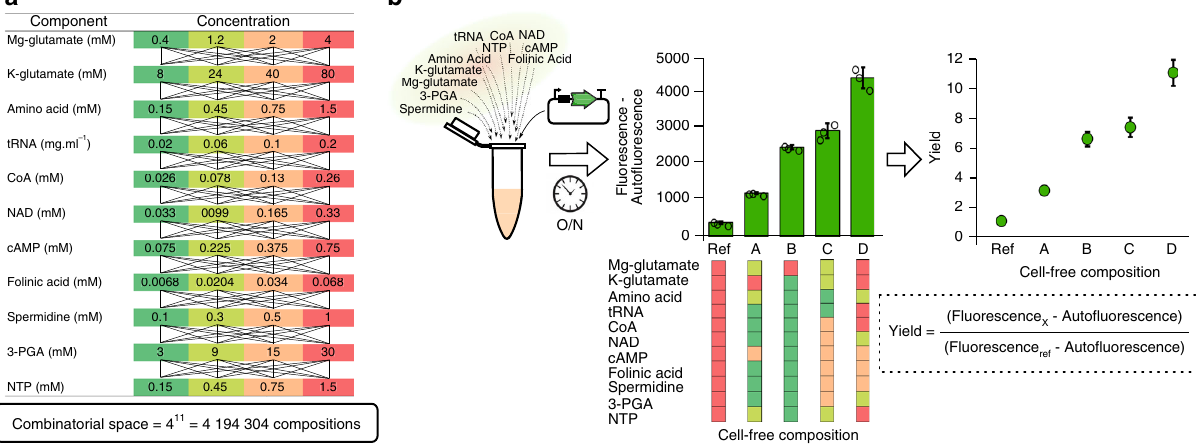
Fig. 1 Combinatorial space of the buffer composition of a cell-free system. a List of chemicals added to the cell-free mix in addition to PEG-8000, HEPES, and the lysate. Four concentrations have been chosen for each chemical. The concentration in red is the highest concentration, then orange, light green, dark green stand for 50, 30, and 10% of the highest concentration. b An example of fl uorescence obtained using four cell-free compositions with our plasmid (10 nM). The auto fl uorescence value is measured with the reference composition without DNA and subtracted from every measurement in the plate. The yield is the ratio between the fl uorescence of a composition x and the fl uorescence of the reference composition. Data are mean values and the vertical black lines stand for the standard deviation of the three replicates ( n = 3 independent samples). Source data are provided in the Source Data fi